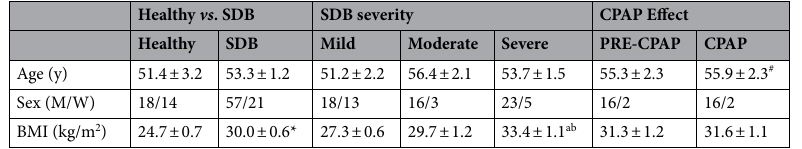
Table 4. Subjects characteristics. Healthy: control group, n: 32 SDB: Sleep Disordered Breathing, n: 78; Snorer/ Mild: subjects with less than 15 events/hour (n: 31); Moderate: between 15 and 30 events/hour (n: 19); Severe: more than 30 events/hour (n: 28). Pre-CPAP and CPAP: SDB subgroup before and after CPAP treatment (n: 18). BMI: Body Mass Index. All data are expressed as mean ± SEM, except for the men/women ratio. *Indicates statistical differences between healthy and SDB patients (General Linear Model, p < 0.05). For mild, moderate and severe SDB groups, “a” indicates statistical differences when compared to mild SDB patients, “b” indicates statistical differences with moderate SDB patients (General Linear Model, p < 0.05, Bonferroni’s post hoc). # Denotes statistical differences between pre-CPAP and post-CPAP treatment (Mixed Model Analysis, p <